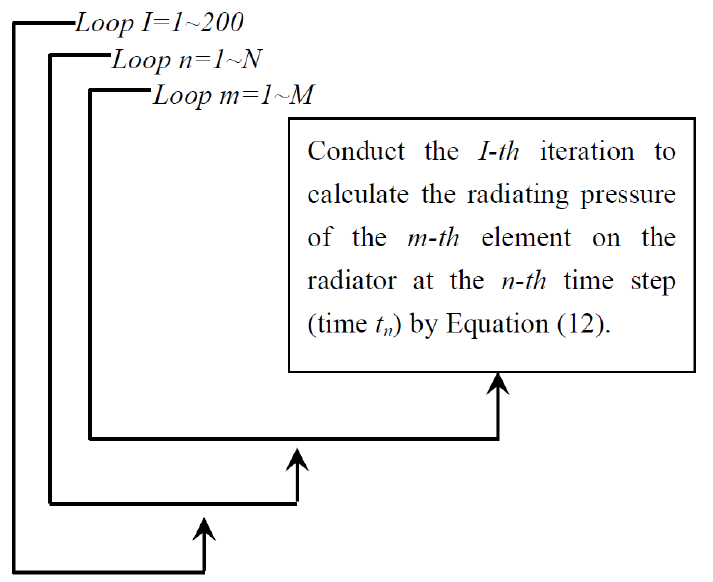
Figure 3. The iterating process for computing the radiating pressure.